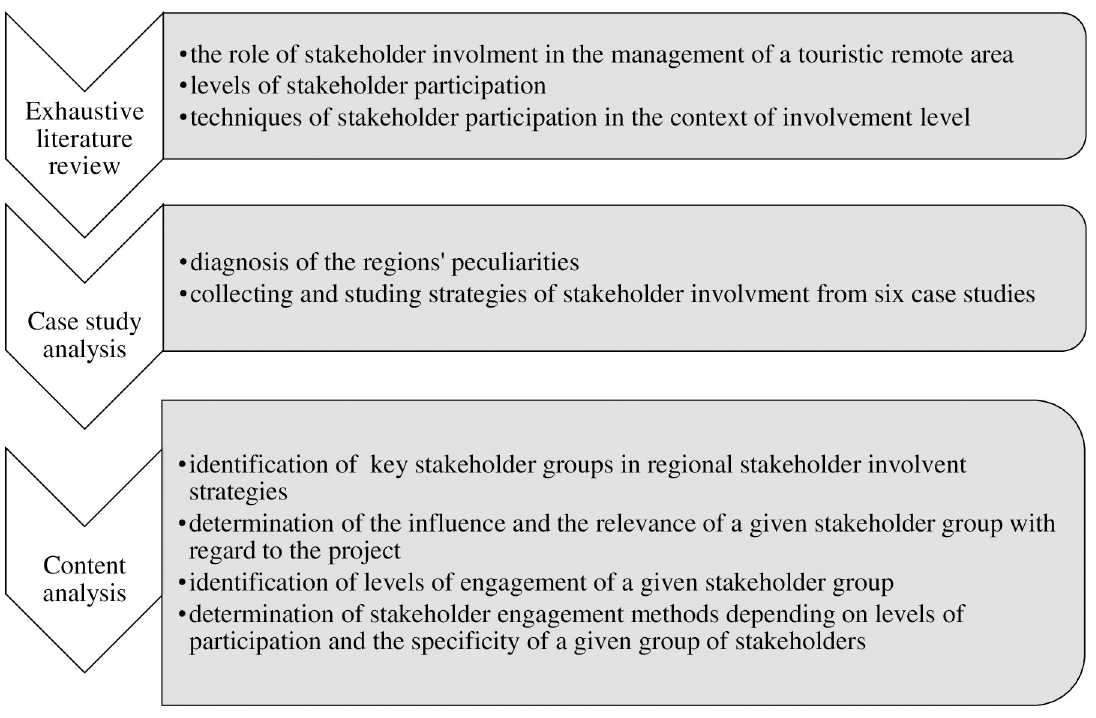
Fig 2. Stages and tasks of the research process. Source: Own